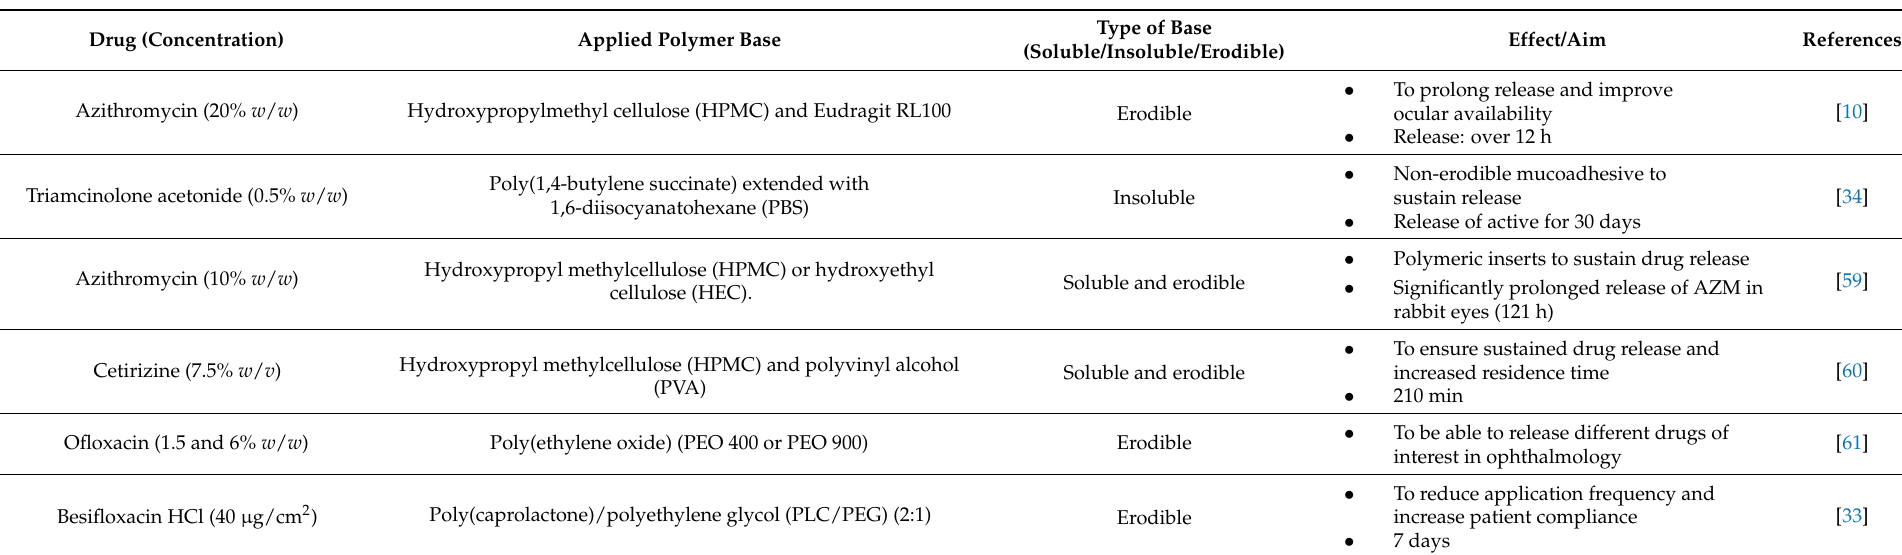
Table 2. Ocular inserts formulations and base